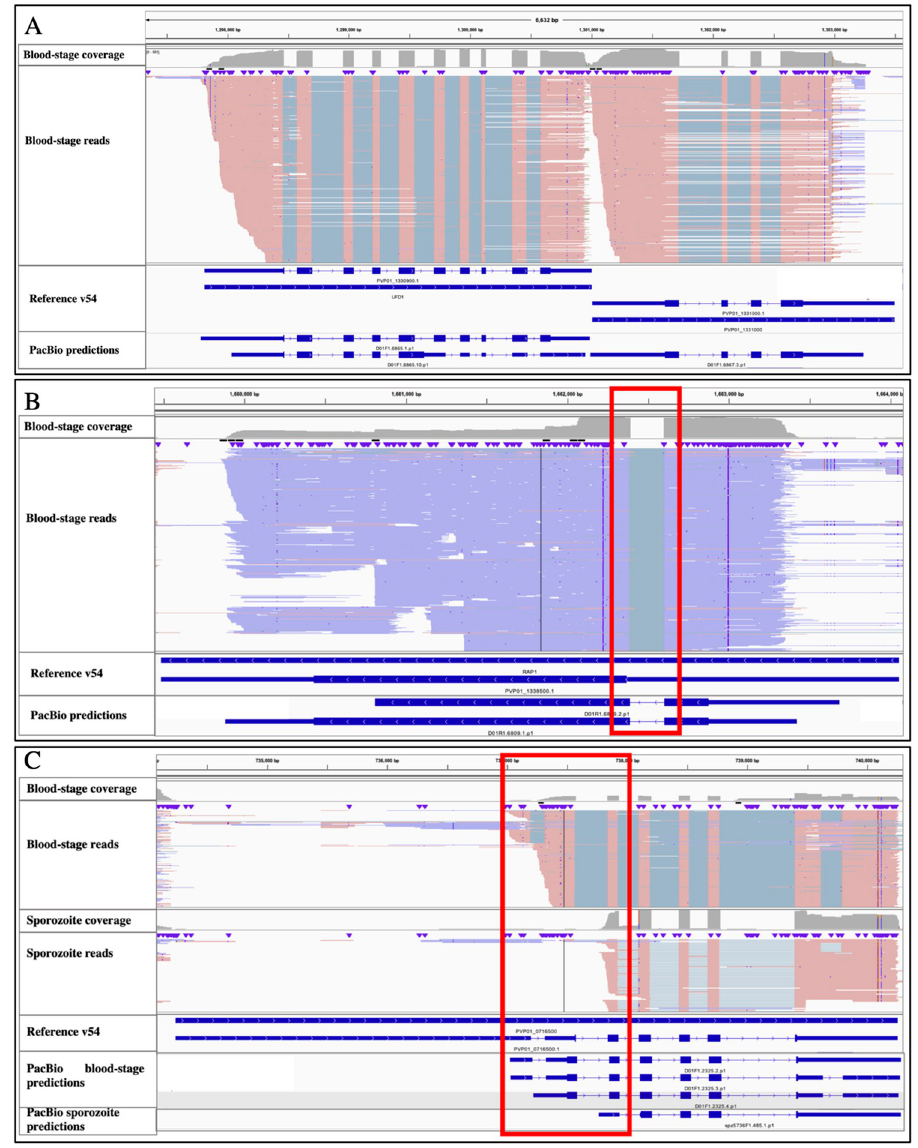
Fig 2. Examples of full-length isoform sequencing using PacBio and resulting transcript predictions. ( A ) Example of protein-coding transcripts matching the current gene annotations. The figure shows 5.7 kb of chromosome 13 containing two annotated P . vivax genes, the ubiquitin fusion degradation protein 1 (PVP01_1330900) and an ATP synthase-associated protein (PVP01_1331000). The blue horizontal bars at the bottom shows the annotations for these genes in plasmoDB v54, while the top panel shows the PacBio reads mapping to this locus (each red horizontal line is a unique read mapped to the positive strand with the grey lines indicating spliced introns). Note that, while the PacBio reads support a shorter 3’-UTR than annotated for PVP01_133100, the predicted protein coding sequences are identical to the ones annotated. (B) Example of protein coding transcript differing from the current gene annotation. The figure shows 5 kb of chromosome 13 surrounding the rhoptry-associated protein 1 (RAP1, PVP01_1338500). The PacBio reads (mapped to the negative strand and displayed in blue) support the presence of an unannotated intron (red box), leading to additional predicted coding sequences upstream of this intron, and a different protein than annotated in the genome (thick blue bars at the bottom). (C) Example of two isoforms with different predicted protein coding sequences. The top panel shows that blood-stage parasites express a transcript for cytochrome b5-like heme/ steroid binding protein (PVP01_0716500) identical to the annotated protein-coding sequence (although with a shorter 5’-UTR). The middle panel shows that P . vivax sporozoites express this gene from a different start site (red box) resulting in a shorter transcript and a different predicted protein. (Note also the presence of an unannotated, and alternatively spliced, intron in the